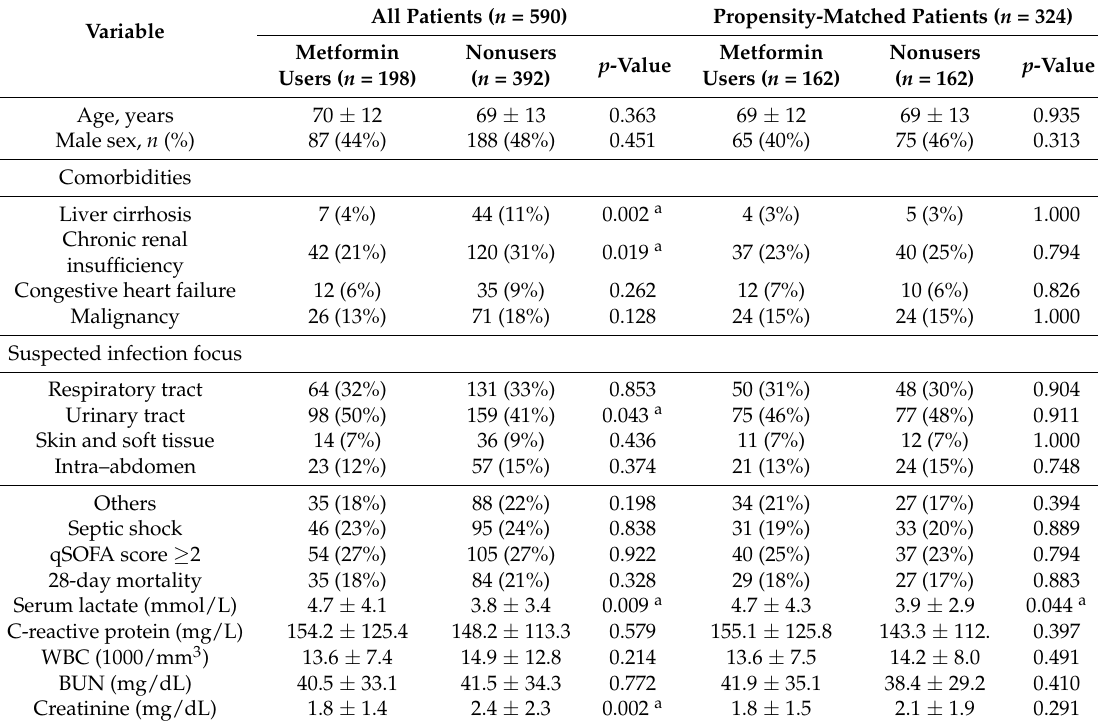
Table 1. Demographics and clinical characteristics of all patients and propensity–matched